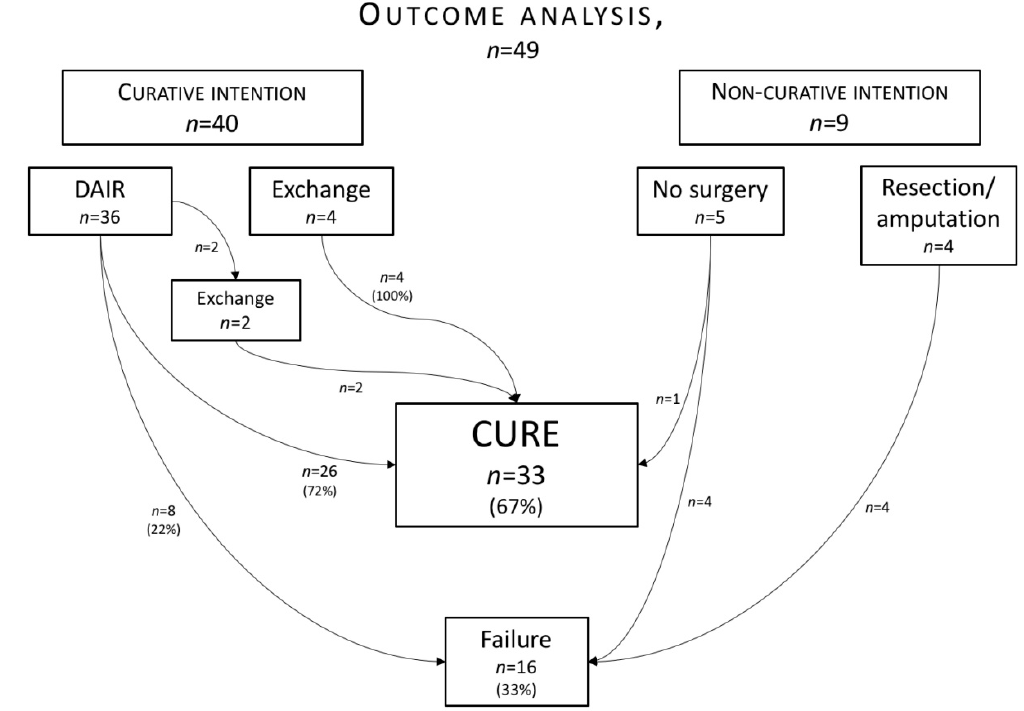
Figure 2. Outcome analysis and surgical treatment. In the top row cases are divided into groups according to treatment intention. In the second row the surgical treatment alternatives are reported. Outcome according to treatment is visualized by arrows with corresponding number of cases.